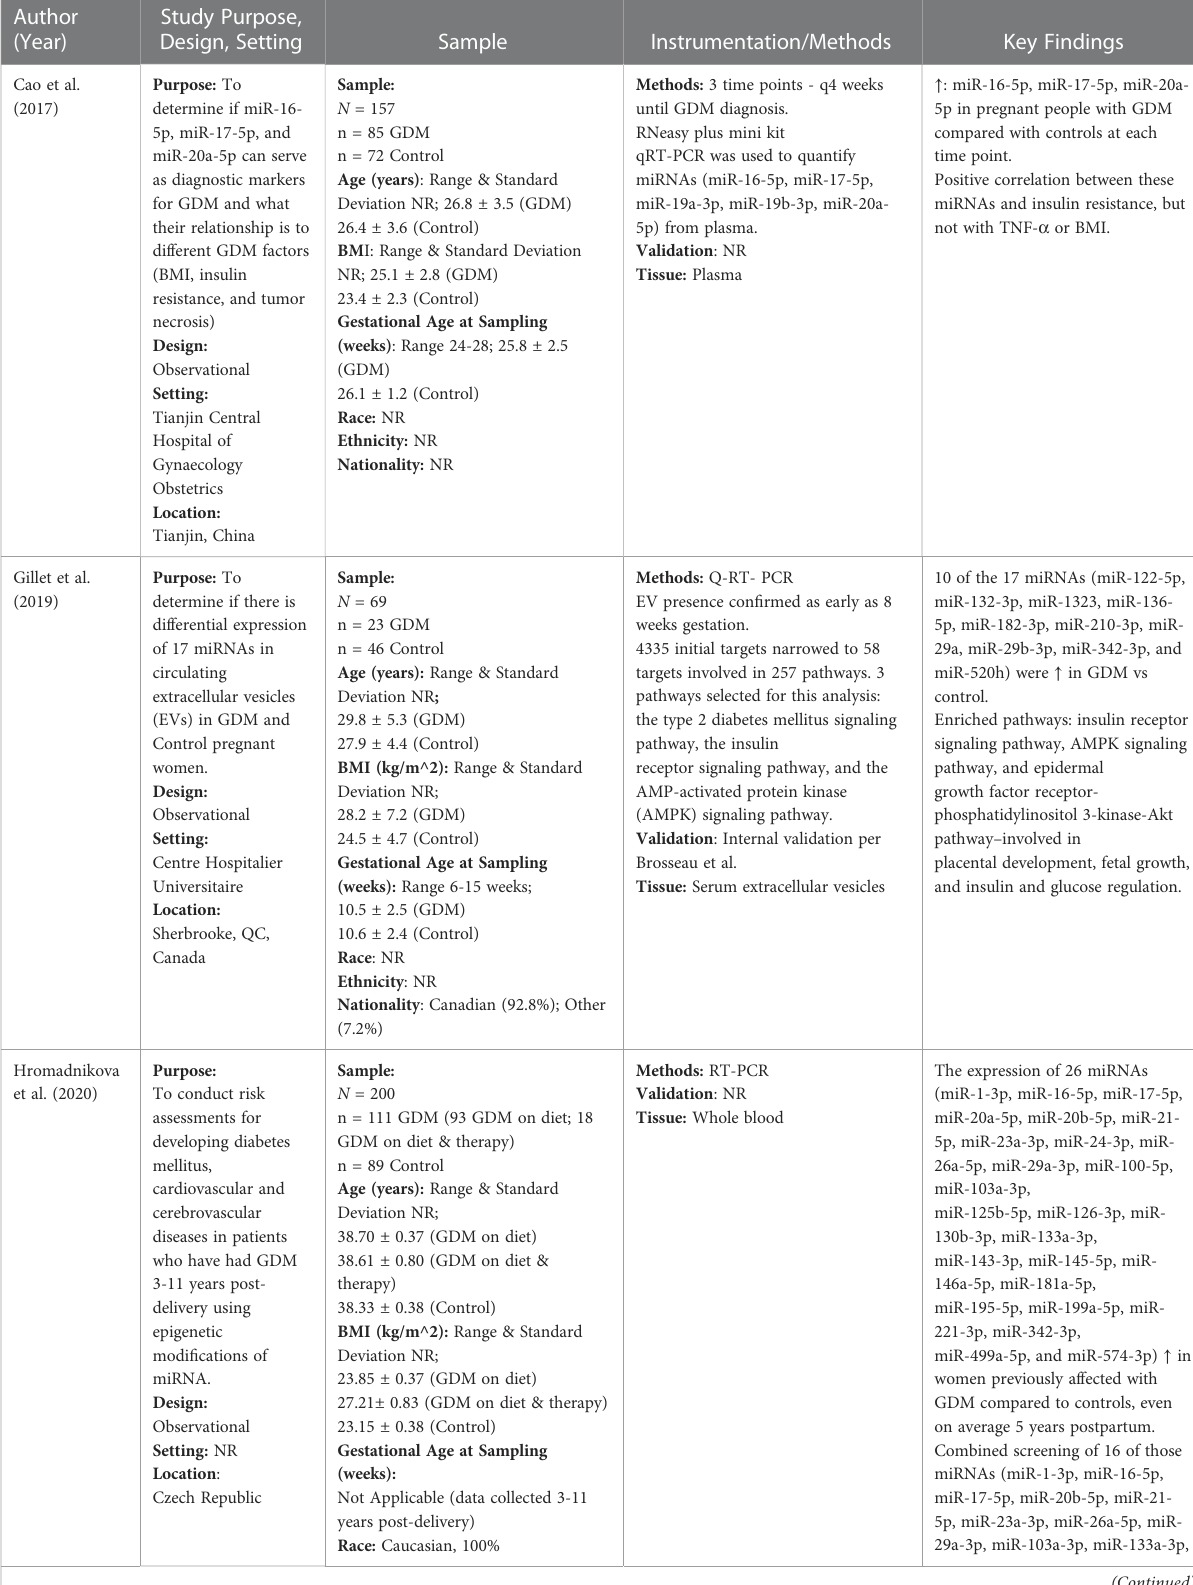
TABLE 2 Summary of micro-RNA (miRNA) studies included in the fi nal